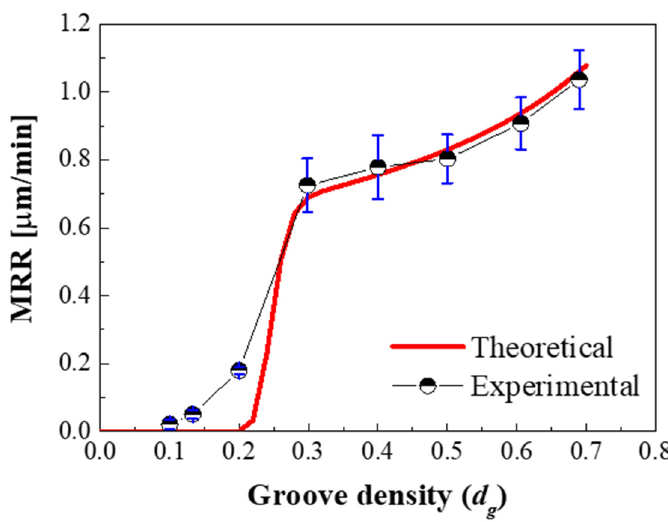
Figure 15. Comparison of modified theoretical material removal rate with experimental results according to groove density.